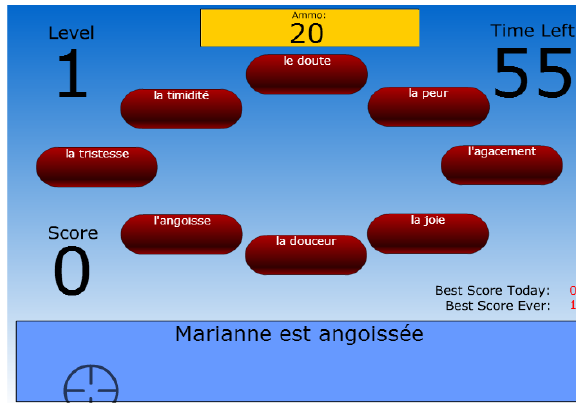
EAI Endorsed Transactions